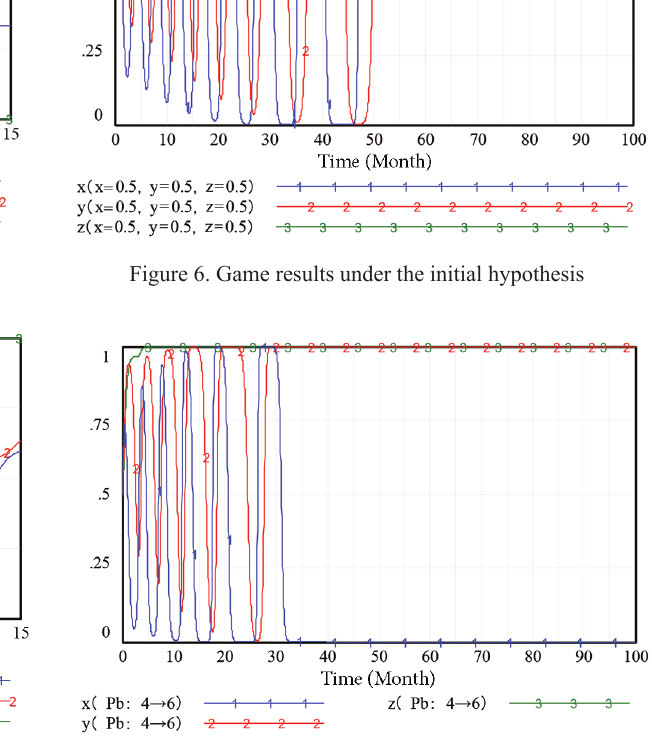
Figure 5. Game results exist mutation (λ 9 )